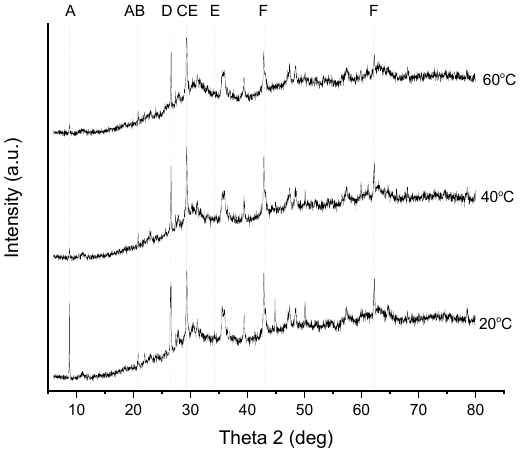
Figure 6. X-ray diffraction patterns of the solid precipitates in the synthetic solution experiments at different temperatures. (A) NH 4 Ca 2 H 3 (P 2 O 7 ) 2 · 3H 2 O; (B) NH 4 MgPO 4 · 6H 2 O; (C) CaO; (D) Mg 3 (PO 4 ) 2 ; (E) CaHPO 4 · 2H 2 O; and (F)